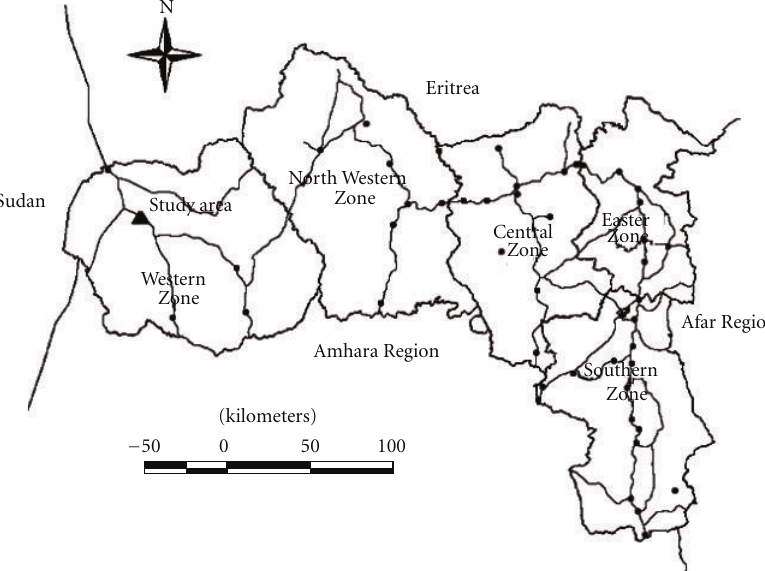
Figure 1: Map of Tigray regional state showing the study